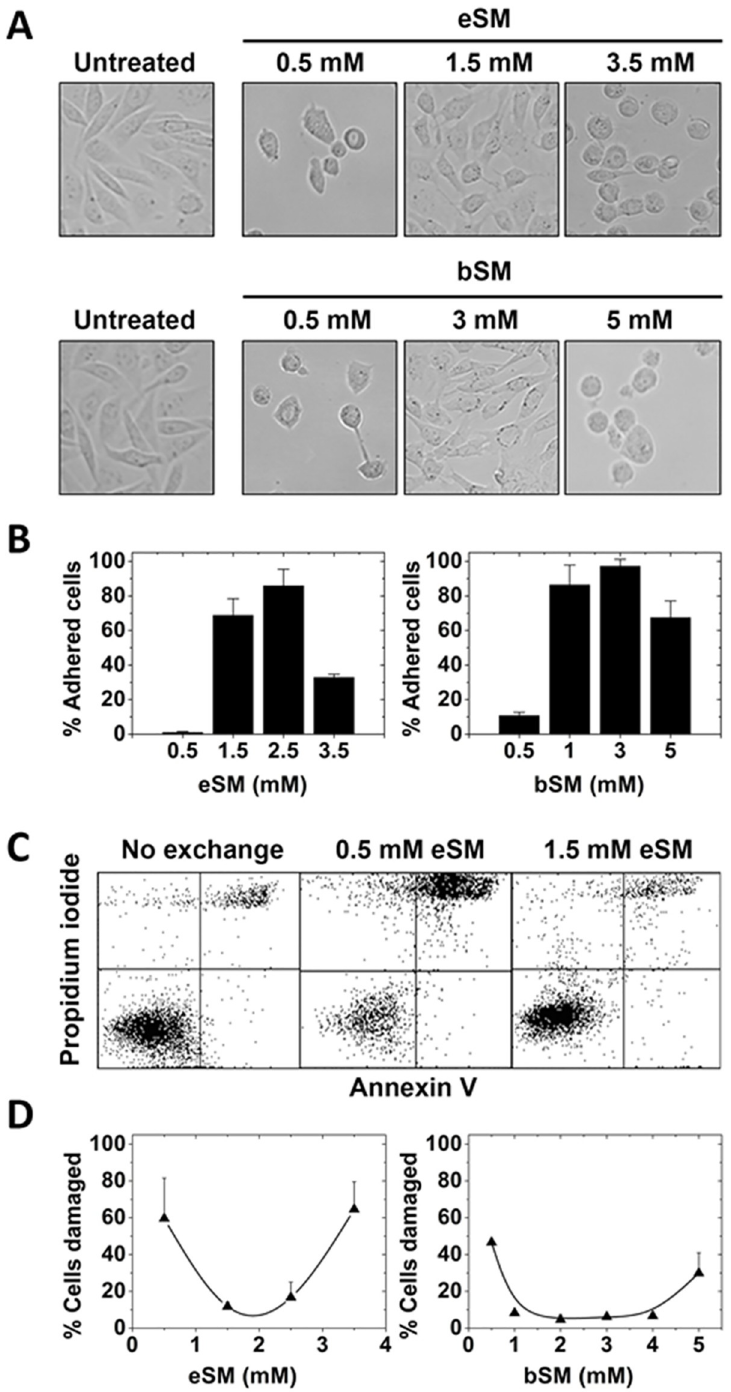
Fig 3. SM concentration used for lipid exchange affects cell morphology and membrane damage of CHO cells. A. Cell morphology. Bright-field microscopy images of cell morphology after exchange at indicated concentrations. B. Fraction of cells attached to plates after lipid exchange and two washes with DPBS. (See S5 Fig. for raw data with axis values.) C. Example of dot-plot graph of flow cytometric analysis of PI and Annexin V staining after lipid exchange. D. % of cells damaged after exchange as judged by PI and annexin V staining (see Methods). Exchange was carried out in 3.5 cm diameter plates at 37˚C with 1 ml of lipid plus 50 mM M α CD. For D. mean and standard deviation from three experiments is